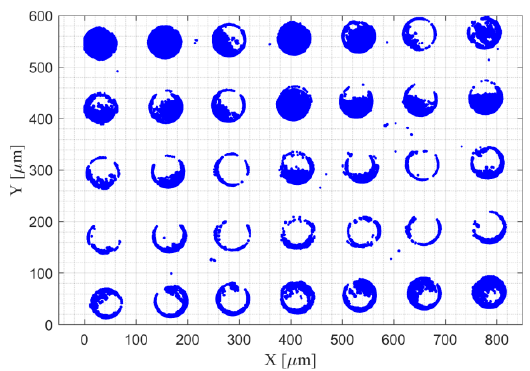
Figure 5. Surface reconstruction of the data of cylinders.